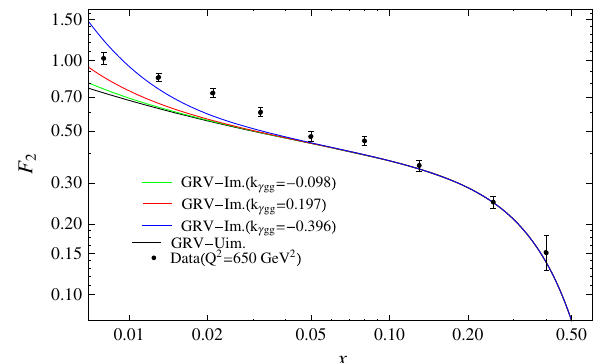
Fig. 4 Our results for the modified nucleon structure function (NSF), F 2 ( x ) ,versusBjorken x variableat Q 2 = 650 GeV 2 ,usingthreediffer- ent numerical values for the K γ gg parameter which are compared with the available experimental data [64] and the normal GRV parametriza- tion model [51]. The plots relate to (cid:4) NC = 4000 GeV . Here “GRV- Im.” indicates our results for the modified NSF, using the GRV model. “GRV-Uim.” denotes the normal NSF in the GRV model GRV Im. k γ gg 0.396